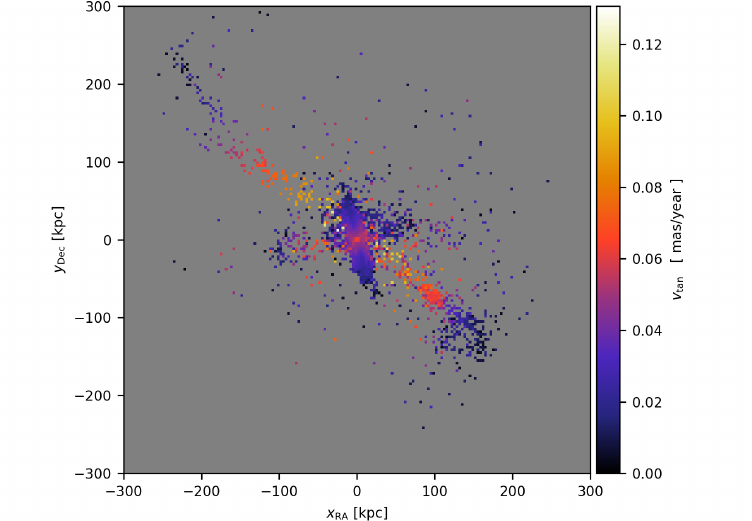
Figure 3. Map of the magnitudes of proper motions of the material at the Andromeda galaxy simulated by B18. The galaxy is viewed from the position of the Sun in the simulation. Proper motion of the whole system was